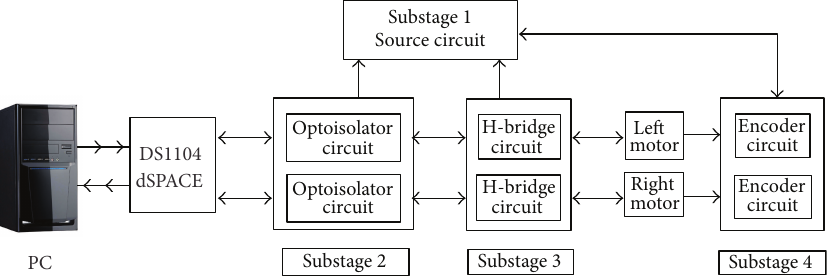
Figure 9: Views of both mechanical design and the real prototype.